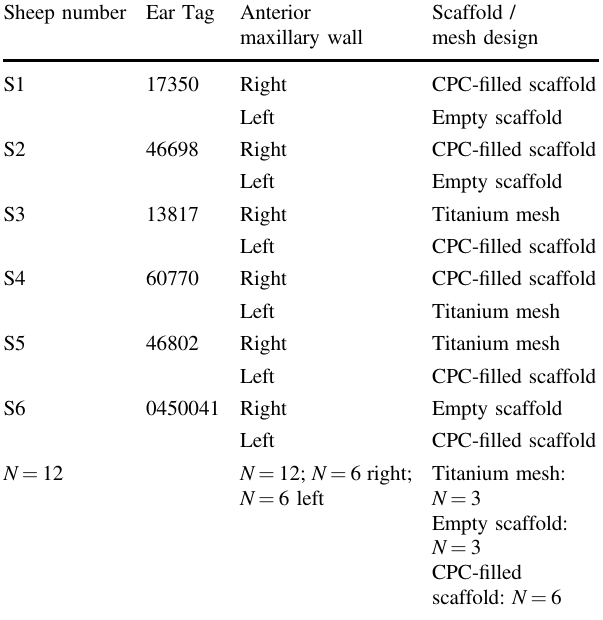
Sheep number Ear Tag Anterior